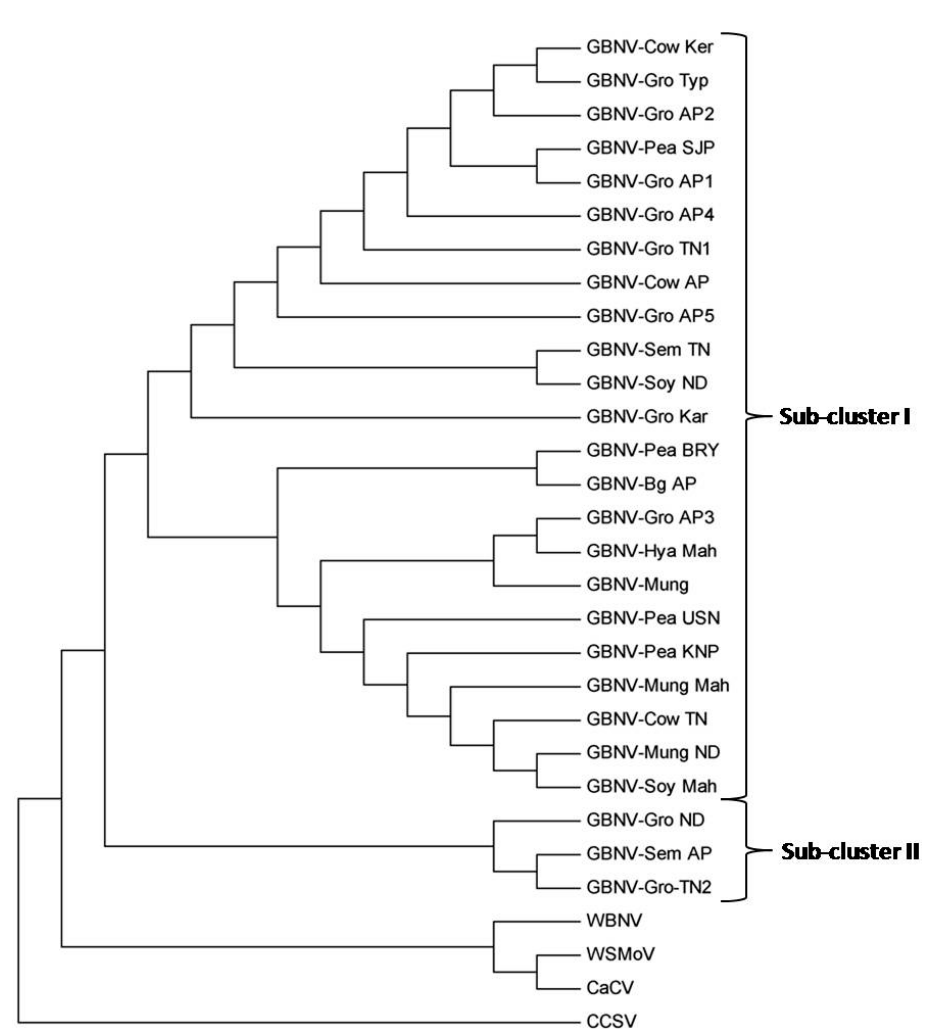
Figure 2. Cluster phylogram illustrating phylogentic relationship based on multiples alignments of amino acids sequences of 26 NP gene of GBNV isolates from Fabaceous hosts and 4 tospoviruses of the WSMoV